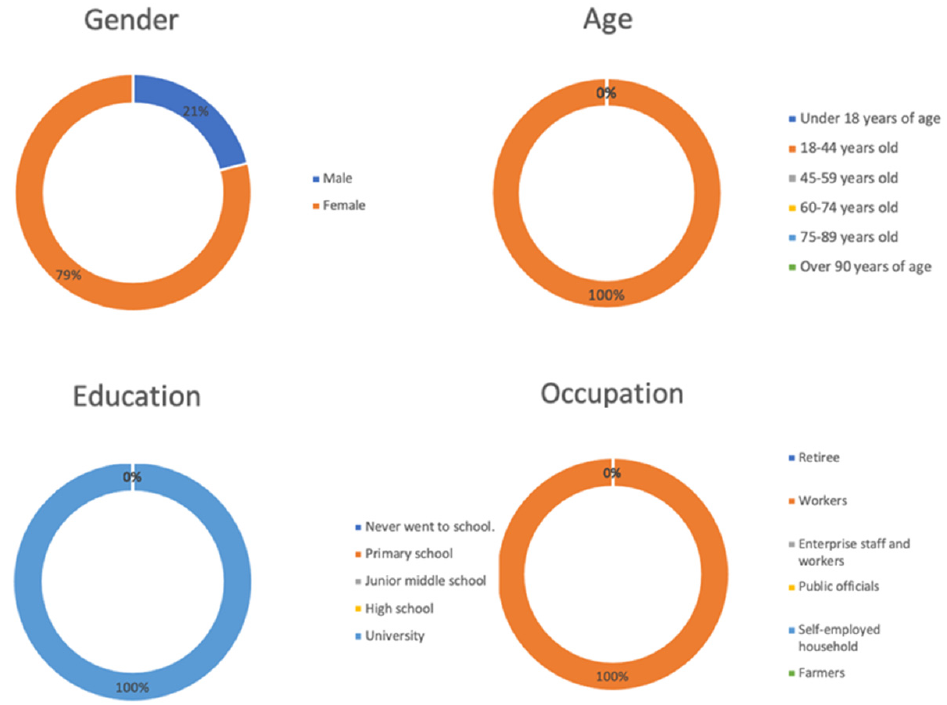
Figure 7. Basic information of participants in the physiological experiment.